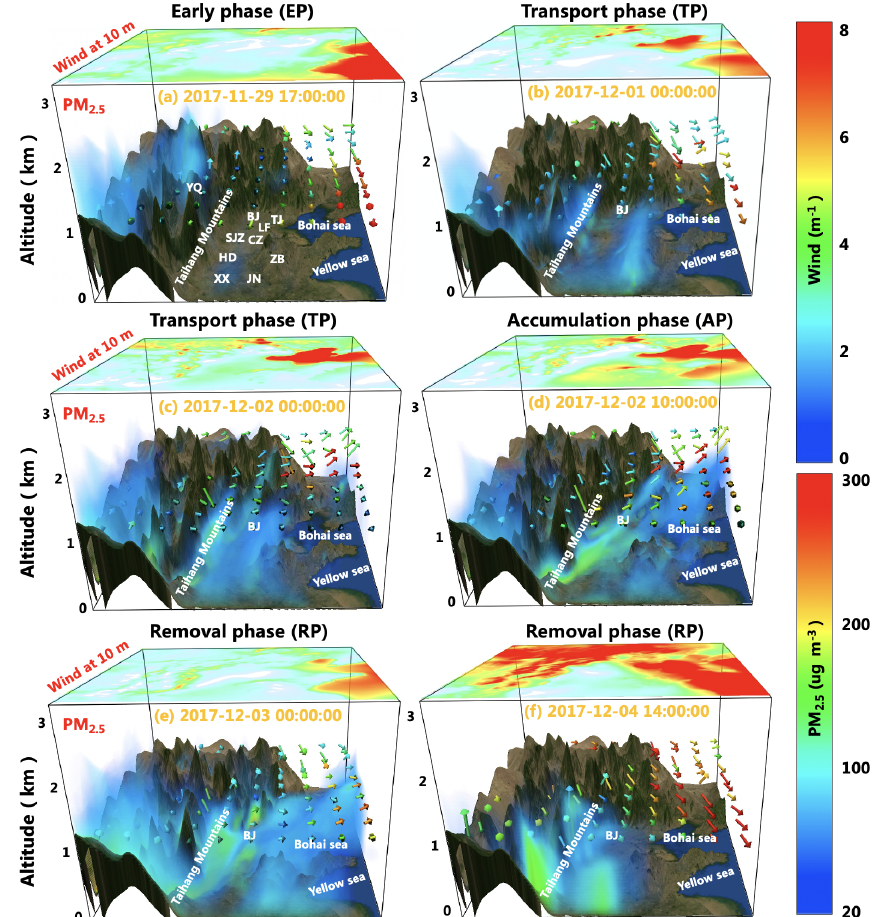
Figure 7. 3-D distribution of PM 2 . 5 during different phases after assimilation. Colors within the boxes depict the PM 2 . 5 concentrations. The color-coded arrows represent the wind direction and speed at 1km. On the tops of the boxes, the spatial distributions of wind speed at 10m are